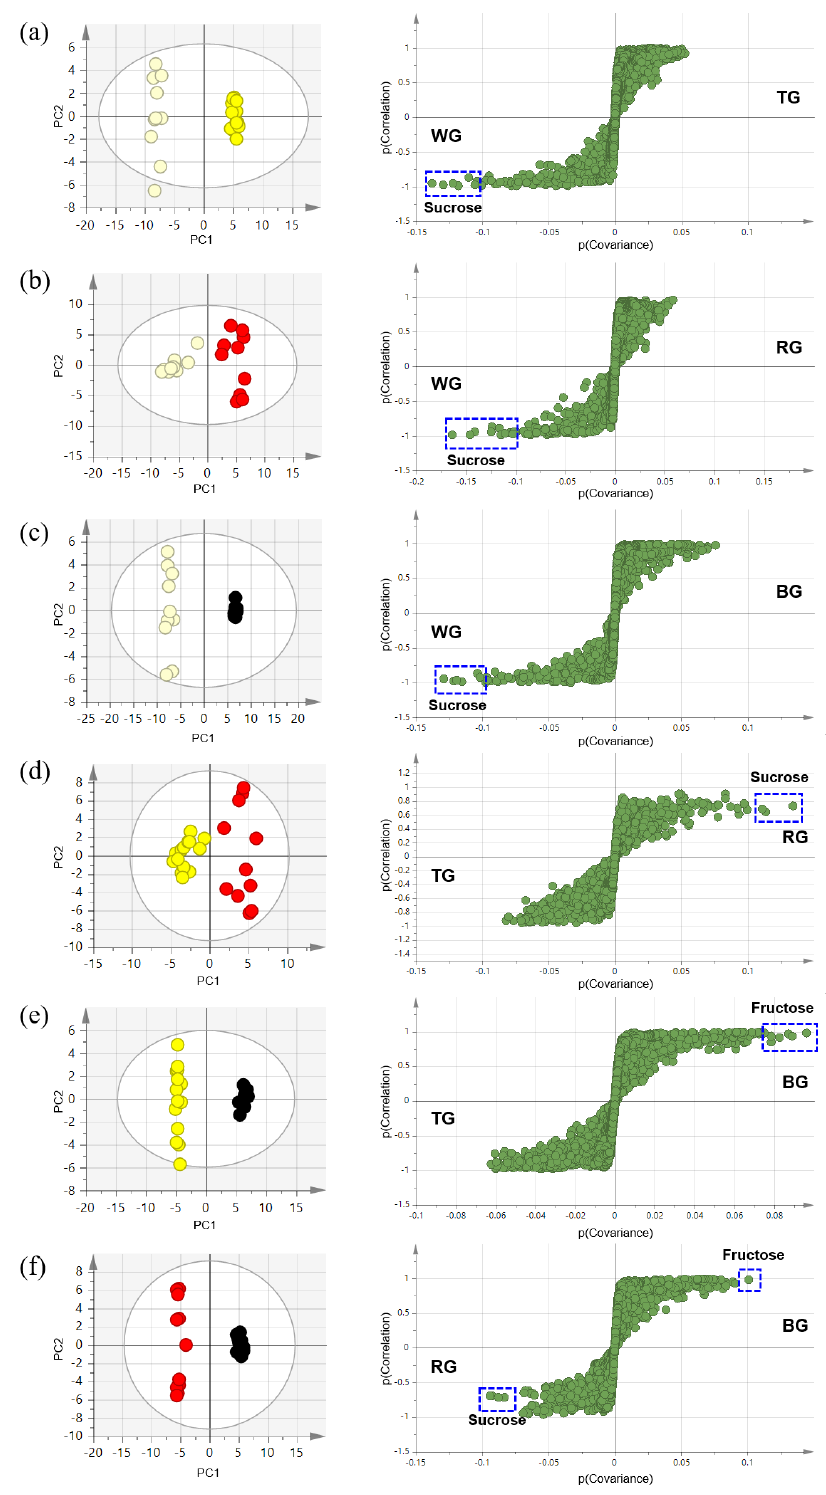
Figure 5. OPLS-DA score plots and S-plots of four processed ginseng products. ( a ) White ginseng vs. tae-geuk ginseng (R 2 X = 0.757, R 2 Y = 0.995, and Q 2 = 0.99). ( b ) White ginseng vs. red ginseng (R 2 X = 0.656, R 2 Y = 0.923, and Q 2 = 0.87). ( c ) White ginseng vs. black ginseng (R 2 X = 0.797, R 2 Y = 0.997, and Q 2 = 0.995). ( d ) Tae-geuk ginseng vs. red ginseng (R 2 X = 0.511, R 2 Y = 0.91, and Q 2 = 0.873). ( e ) Tae-geuk ginseng vs. black ginseng (R 2 X = 0.692, R 2 Y = 0.996, and Q 2 = 0.993). ( f ) Red ginseng vs. black ginseng (R 2 X = 0.608, R 2 Y = 0.994, and Q 2 = 0.984).